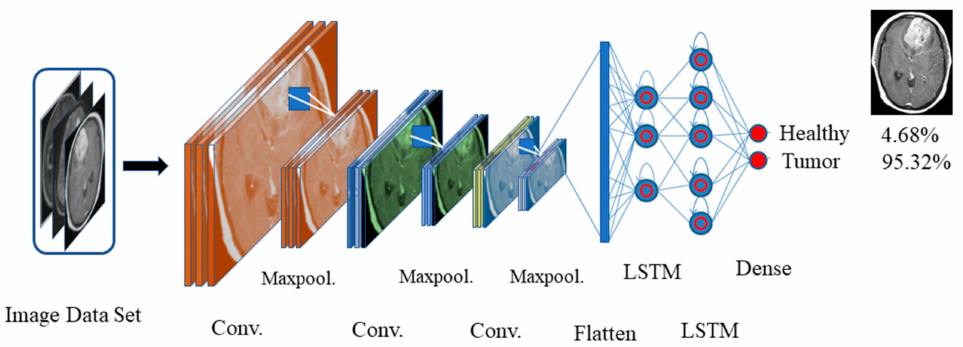
Figure 5. The proposed CNN-LSTM